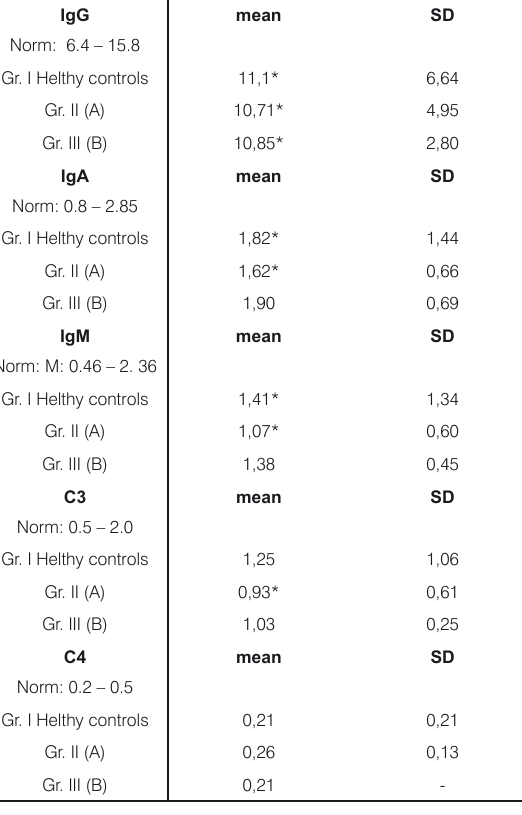
Table 2. Changes of the studied humoral immunity parameters. Table 3. Study of the lymphocyte receptor